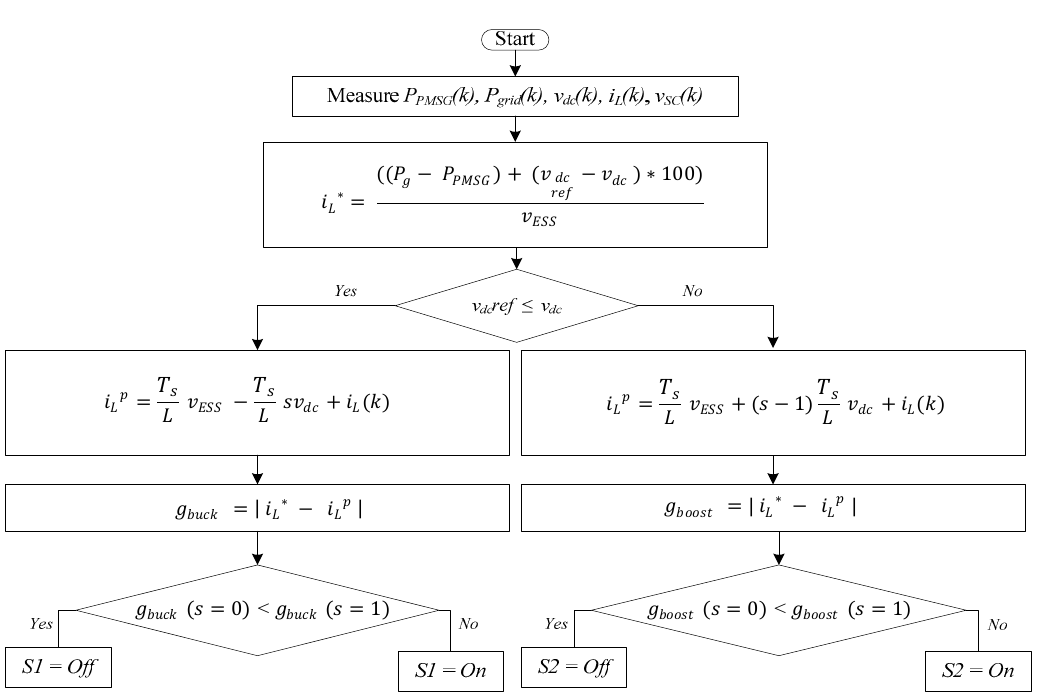
Figure 5. The flow chart of model predictive control (MPC) algorithm of a dc-dc bidirectional converter.